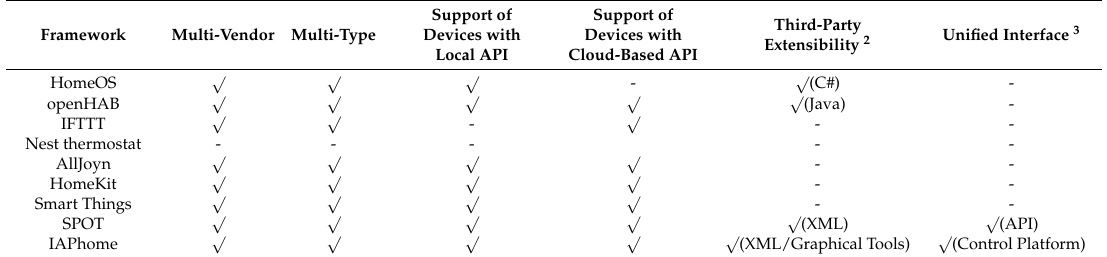
Table 2. Comparison of different smart home frameworks.